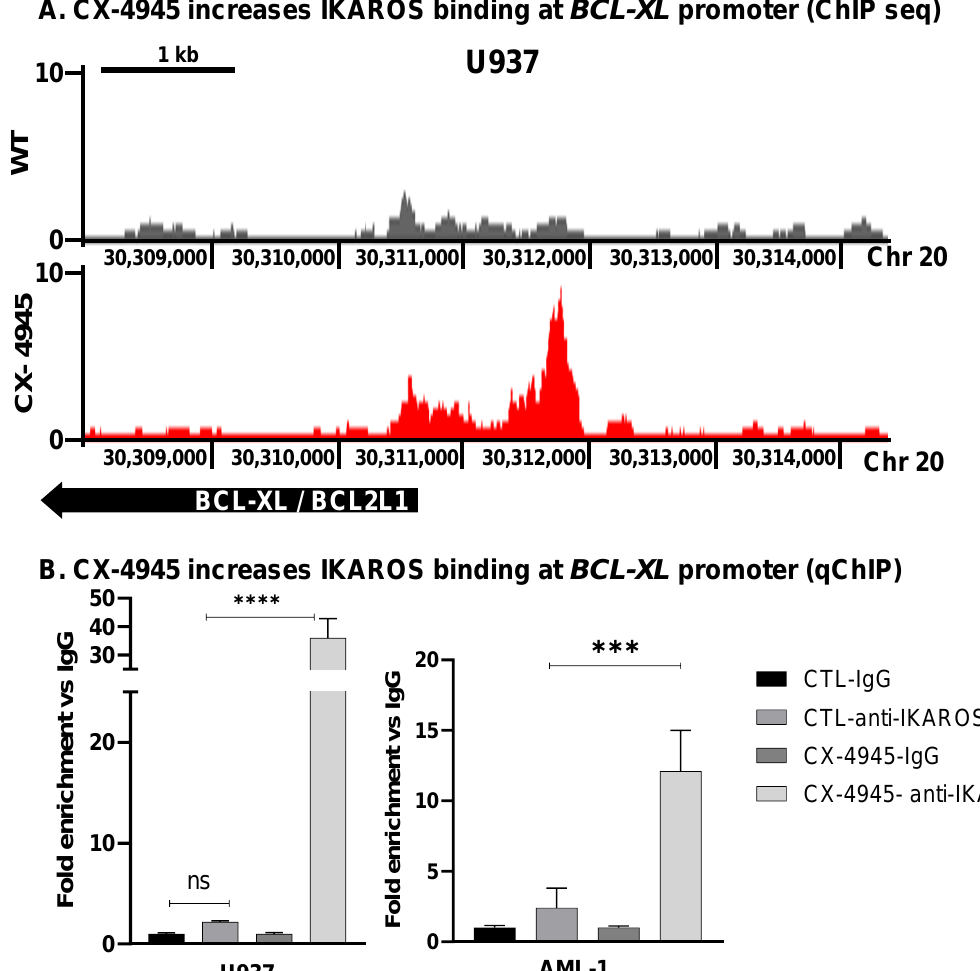
Figure 4. CK2 inhibitor increases IKAROS DNA-binding to BCL-XL . Chromatin immunoprecipitation (ChIP) followed by next-generation sequencing (ChIP-seq) and analysis of genome-wide occupancy of IKAROS was performed on U937 following the CX-4945 treatment at 10 µ M concentration for 72 h. A change in IKAROS binding to promoter regions of the BCL-XL gene was analyzed following the CX-4945 treatment. ( A ) A chIP-seq signal map for IKAROS binding to the BCL-XL/BCL- 2L1 promoter region in U937-untreated labeled as WT (wild-type) (top panel) and CX-4945 treated U937 (bottom panel). Y-axis represents the log-2-fold change enrichment of IKAROS binding (** p < 0.01). ( B ) U937 and primary AML cells (AML-1) cells were treated with 10 and 5 µ M of CX-4945, respectively (based on the IC50 value) for 48 and 72 h. IKAROS binding to the BCL-XL promoter region was confirmed using the qChIP assay in WT and CX-4945 treated cells. Binding at 72 h was not significantly increased compared to the 48 h treatment (not shown in the graph). Results are the mean +/– SD of three independent experiments. P-value summaries are as follows: p > 0.05 (ns-non significant); p < 0.05 (*); p < 0.001 (***); p < 0.0001 (****).